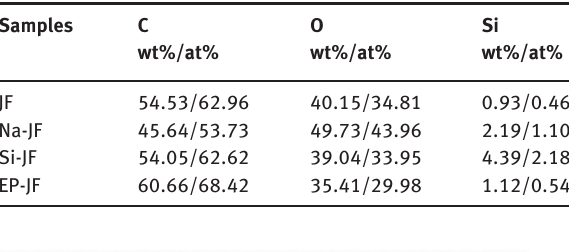
Table 1: SEM/EDX data of JF